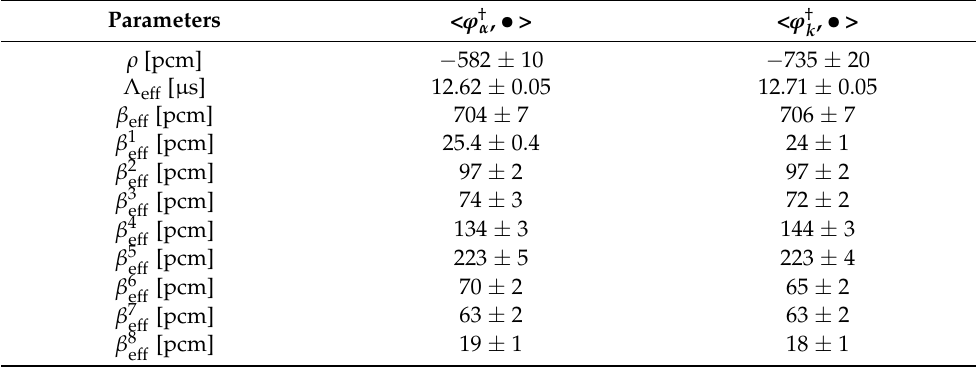
Effective kinetics parameters of Problem III, sub-critical configuration including delayed contributions.